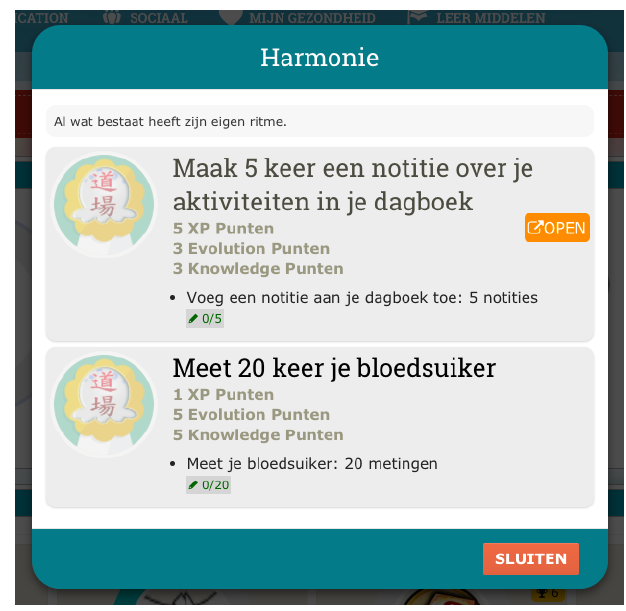
Figure 5. Gamification platform,